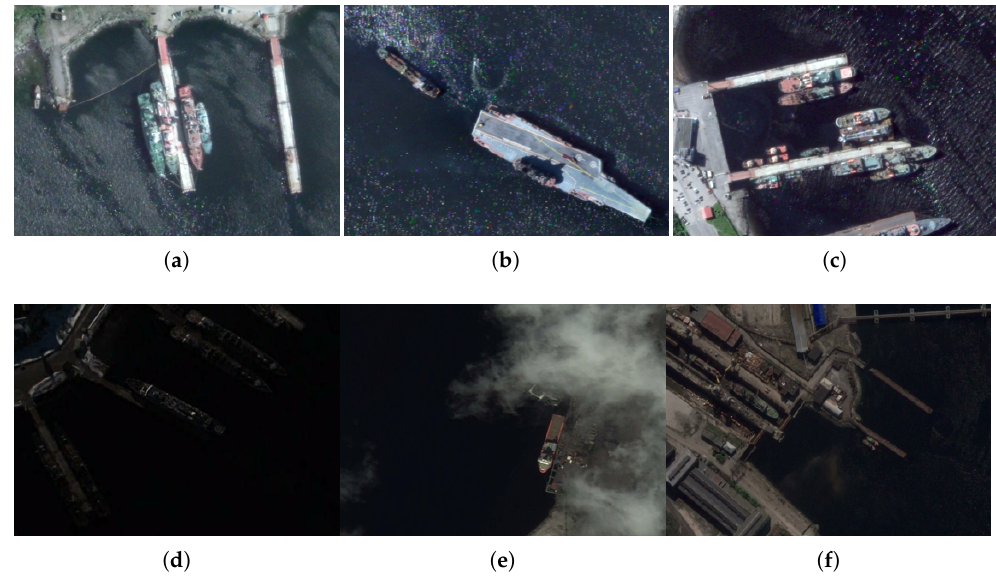
Figure 1. Several examples of new collections in proposed dataset. The new collections include multiple scenarios: Scenes of ( a ) ships docking in shore, ( b ) ships in the middle of the ocean, ( c ) multi-scale ship instances densely arranged in shore, ( d ) a dark night, ( e ) a cloudy day, and ( f ) ships on